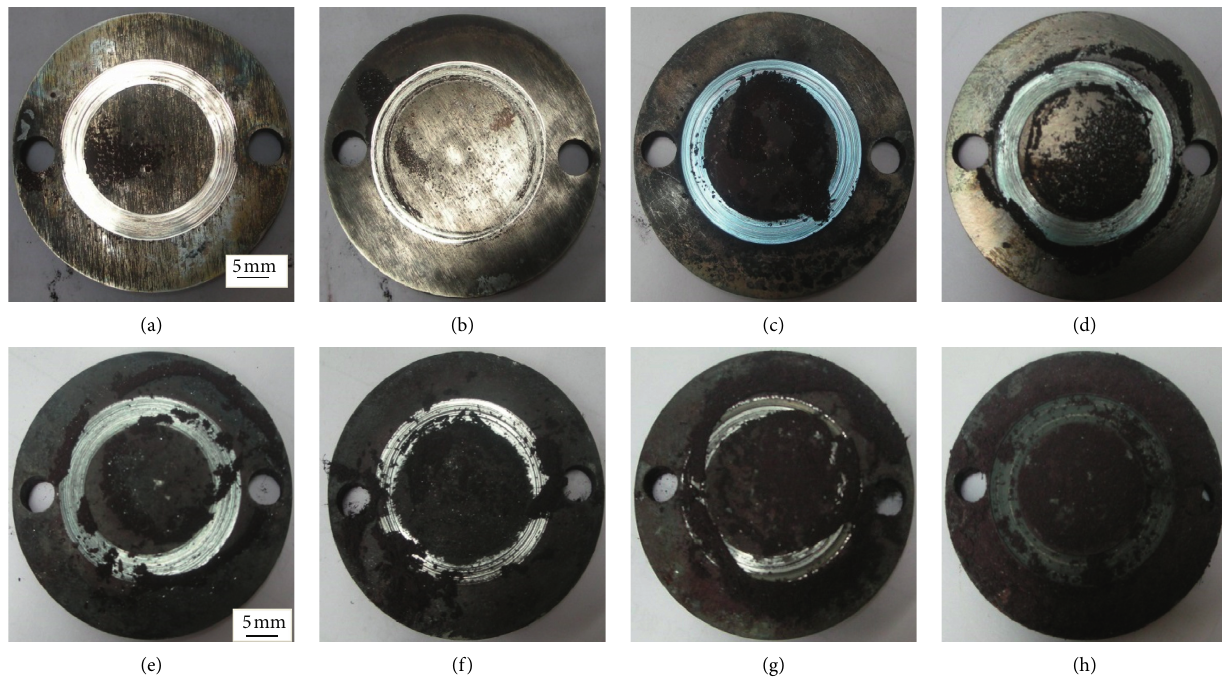
Figure 15: The wear morphologies of lower specimen at different temperatures: (a) room temperature; (b) 200 ° C; (c) 300 ° C; (d) 400 °